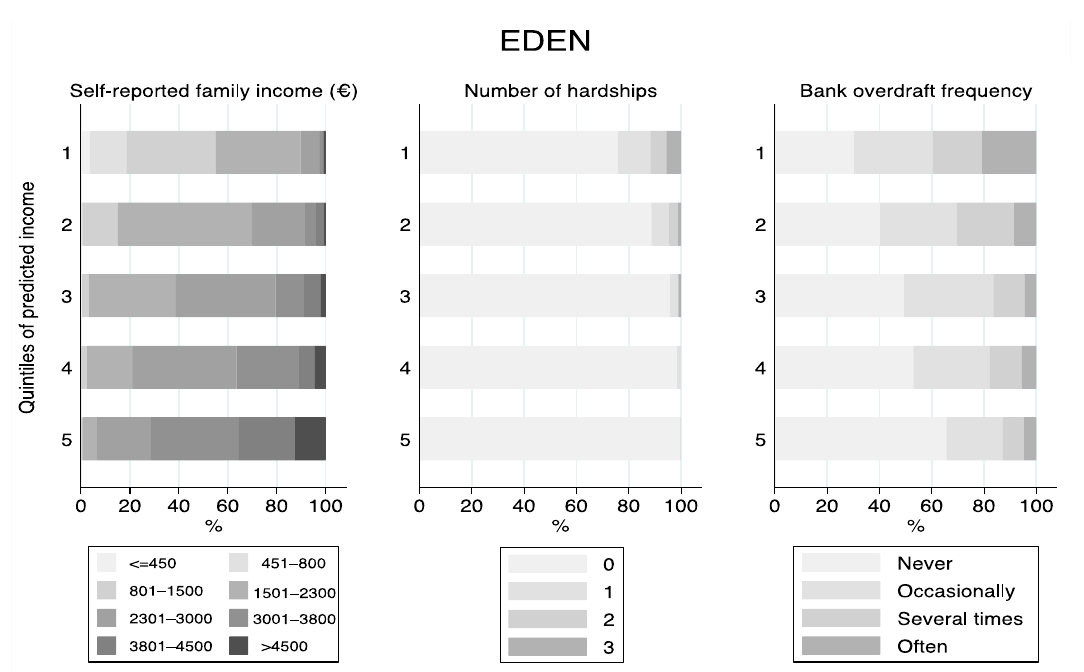
Figure 3. Distribution of the SEP-related variables available in the ELFE cohort by quintiles of the predicted income.